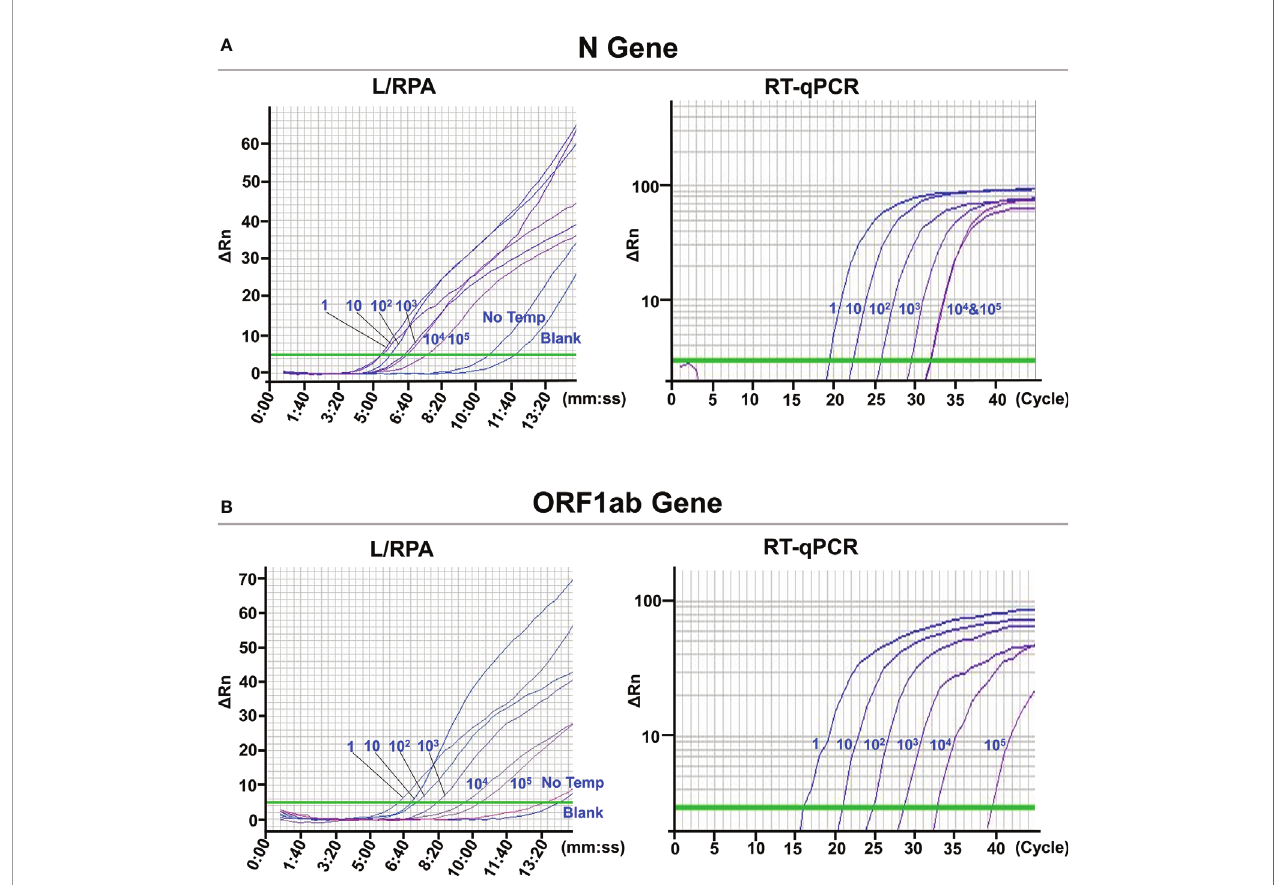
FIGURE 4 | Validation with SARS-CoV-2 pseudovirus. The images were the fl uorescence history diagrams of the detection results of the N gene (A) and the ORF1ab gene (B) of SARS-CoV-2 pseudovirus using the L/RPA assay and RT-qPCR. The diagrams of L/RPA showed the fl uorescence signal ( D Rn) vs . time (mm: ss). The diagrams of RT-qPCR showed the fl uorescence signal ( D Rn) vs . Ct (cycle). The blue numbers beside the curves indicated the dilution multiple of the RNA extracted from the pseudovirus used in the corresponding assays. No Temp: the control with no RNA template. Blank: the control reactions without the ligation reaction components and the RNA template. Every diagram was one typical outcome of three independent